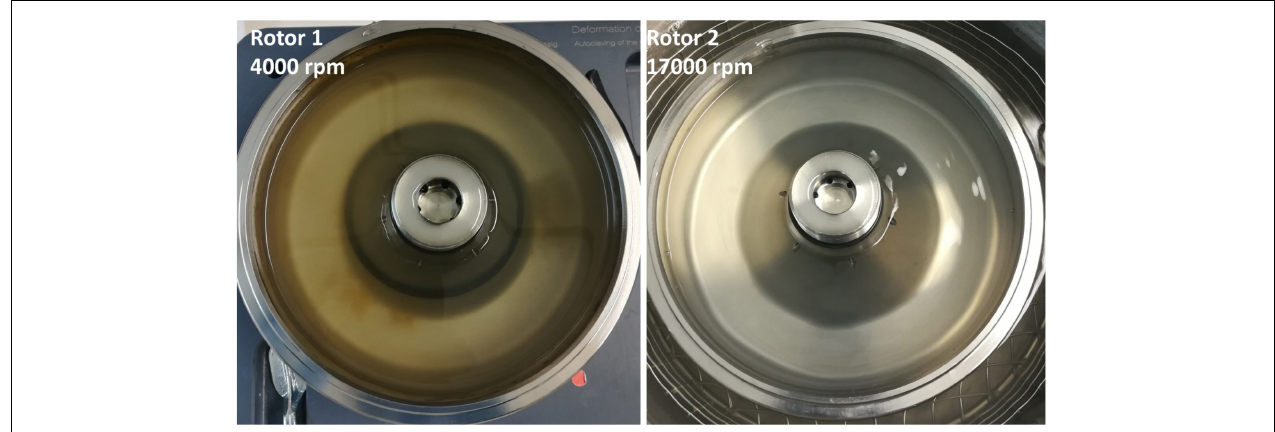
FIGURE 4 | Left: Rotor 1 (4000 rpm) containing most of the plankton particles. Right: Rotor 2 (17000 rpm) containing primarily NPPs.